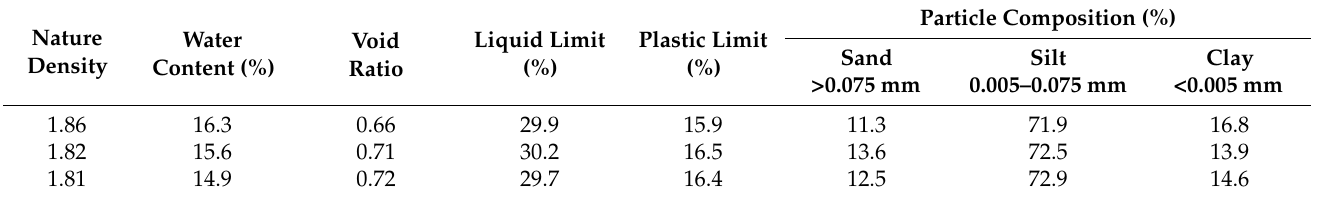
Table 1. Basic physical properties of